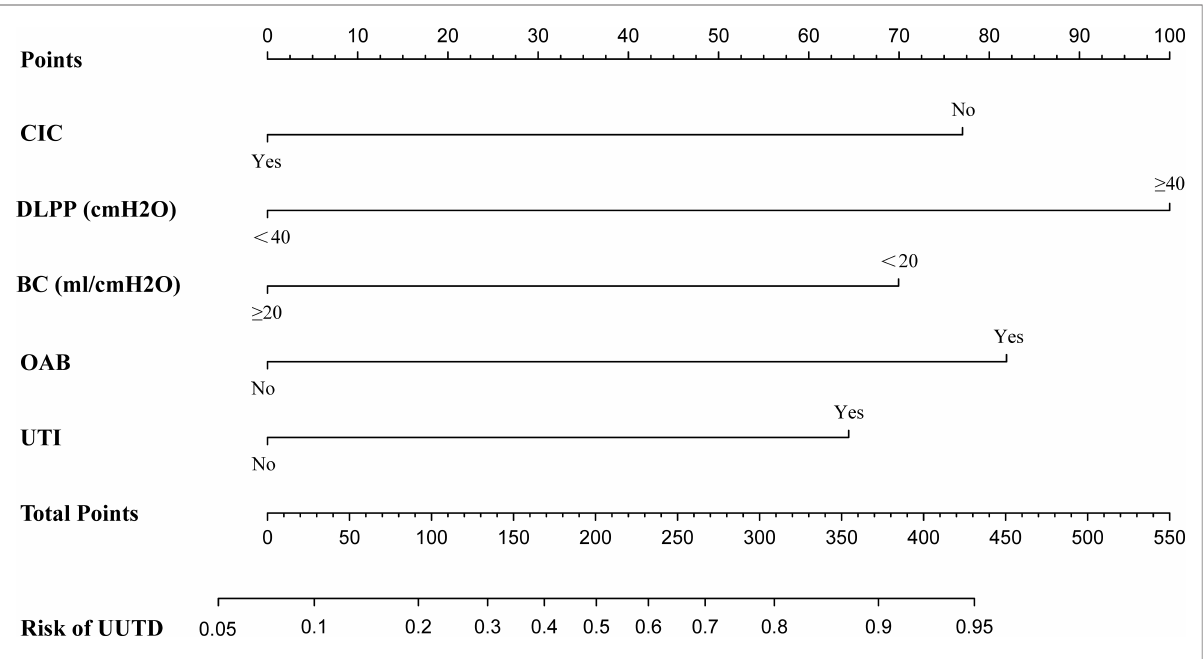
FIGURE 1 Nomogram to estimate the risk of upper urinary tract damage in patients with neurogenic bladder. CIC, clean intermittent catheterization; DLPP, detrusor leak point pressure; BC, bladder compliance; OAB, overactive bladder; UTI, urinary tract infection; UUTD, upper urinary tract damage.